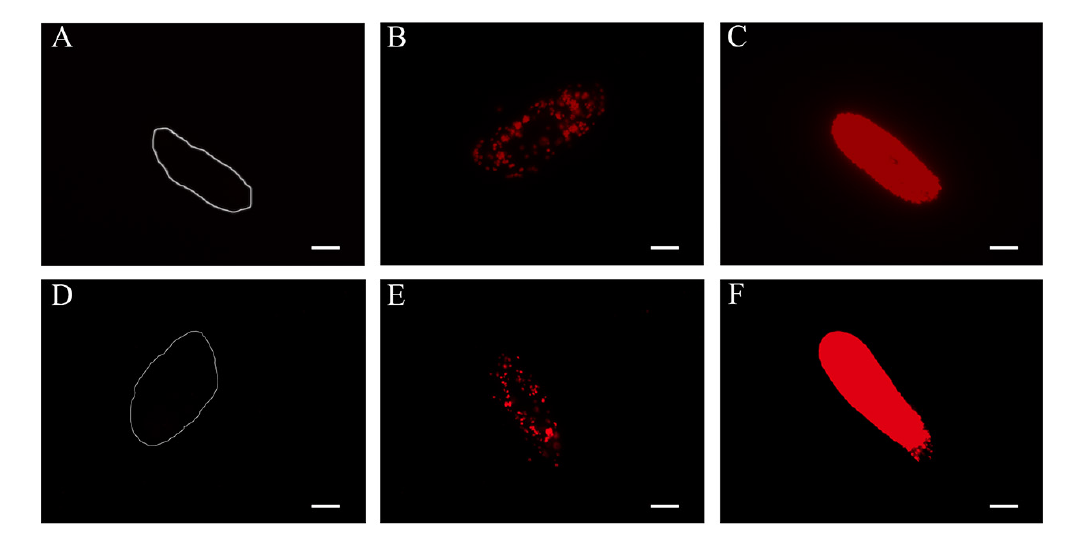
Figure 7. Establishment of symbiosis between aposymbiotic Paramecium bursaria and intracellular algae. Re-establishment of symbiosis between aposymbiotic P. bursaria RanNy with Micractinium conductrix obtained from strain Scot; ( A – C ) and aposymbiotic P. bursaria JPN with Choricystis parasitica ( D – F ). Aposymbiotic Paramecium cells ( A , D ) obtained after treatment with cycloheximide. The white outline corresponds to the ciliate’s cell shape based on bright field microscopy (not shown). Symbiotic status of P. bursaria after four to seven days ( B , E ). Successfully established symbiosis after two ( C ) to four ( F ) weeks. Representative examples are shown. Arrows indicate digestive vacuoles. Scale bars: 20 µ